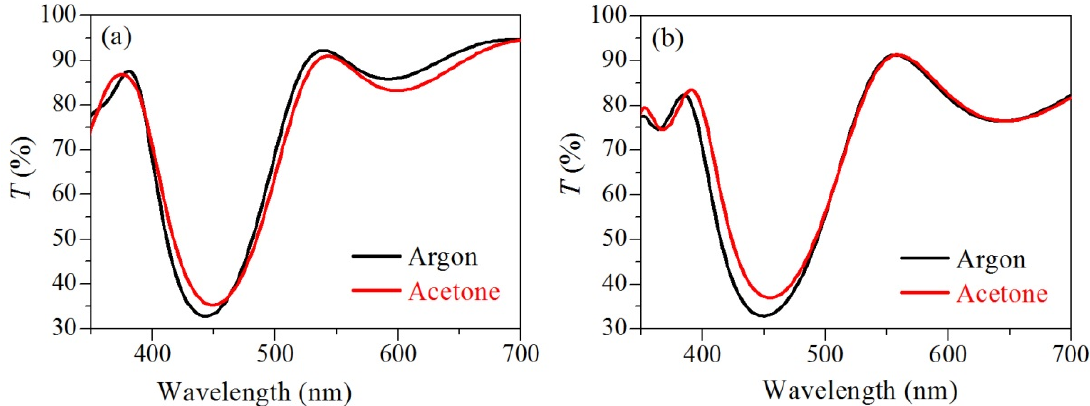
Figure 5. Measured transmission spectra in argon and acetone ambient of 7-layer Bragg stacks, deposited by alternating dense and porous Nb 2 O 5 layers, structured by Pluronic PE6800 ( a ) and PE6200 ( b ) as templates.